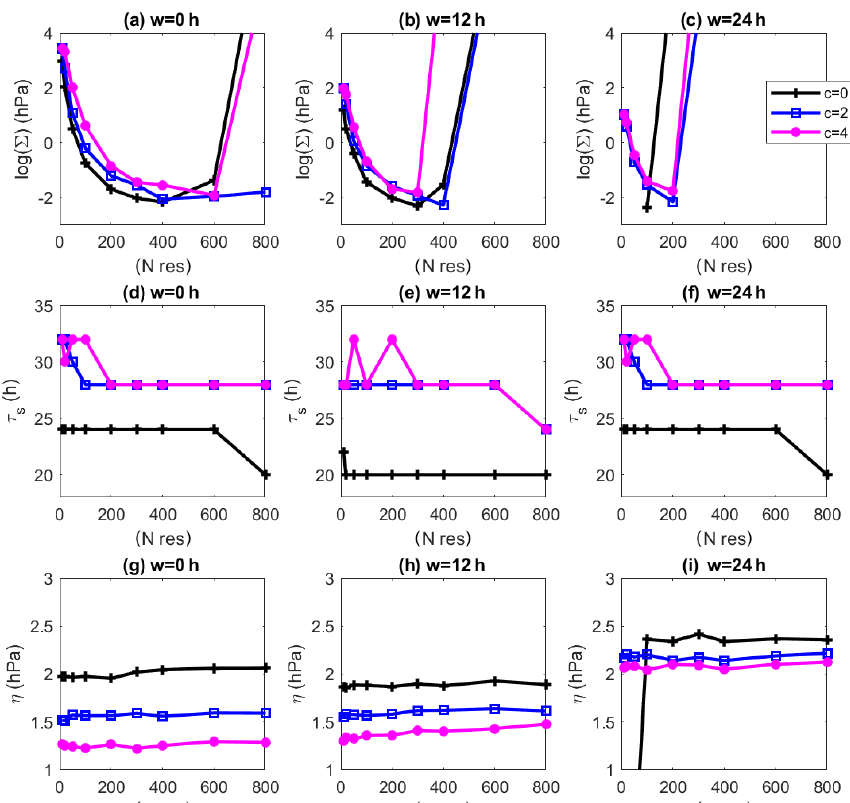
Figure 9. Dependence of the quality of the results for the prediction of the sea-level pressure NCEPv2 data on the coarse-graining factor c and on the moving-average window size w . The observable used is u(t) ≡ (cid:104) SLP (t) (cid:105) lon , lat . (a–c) χ 2 distance log ((cid:54)) ; (d–f) predictability horizon (in hours) τ s , s = 1 . 5hPa; (g–i) logarithm of initial error η . Different coarse-graining factors c are shown with different colours. (a, d, g) w = 0, (b, e, h) w = 12h, (c, f, i) w =